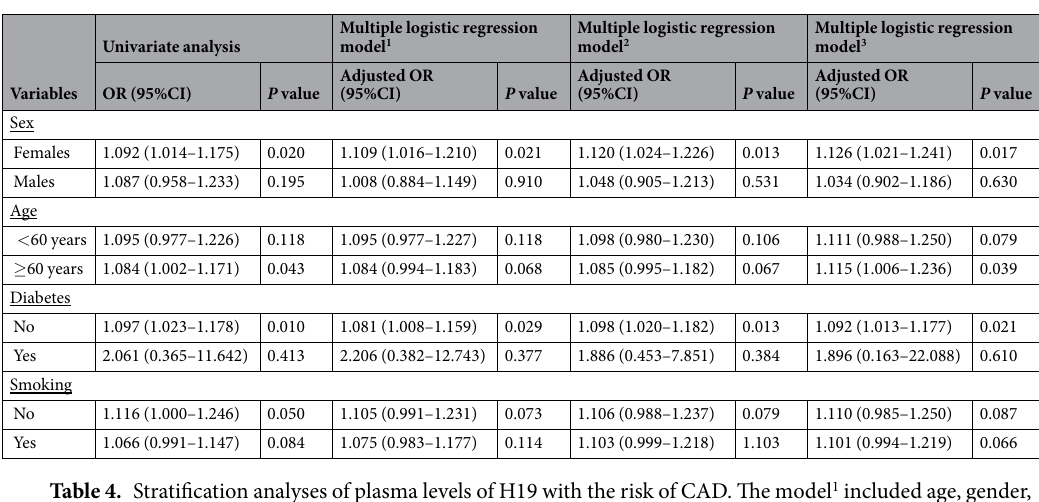
Table 4. Stratification analyses of plasma levels of H19 with the risk of CAD. The model 1 included age, gender, BMI, and smoking. The model 2 included age, gender, BMI, smoking, hypertension, and diabetes. The model 3 included age, gender, BMI, smoking, hypertension, diabetes, TC, TG, LDL-C, and HDL-C. OR, odds ratio; CI, confidence